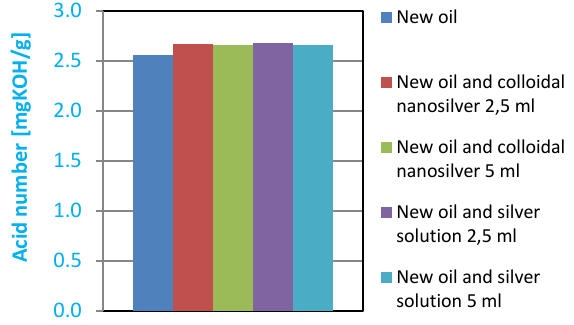
Fig. 6. Acid number of new oil and new oil with colloidal nanosilver and silver solution Similar values can be observed after adding silver so- lution to the oil, i.e. for 2.5 ml and 5 ml, the acid number is 2.682 mgKOH/g and 2.660 mgKOH/g, respectively. Both types of silver there is a slight increase in the acid number in comparison to the acid number for new oil. Any amount and type of silver deteriorates the properties of the oil. Therefore, further testing with the addition of silver to new oil is not